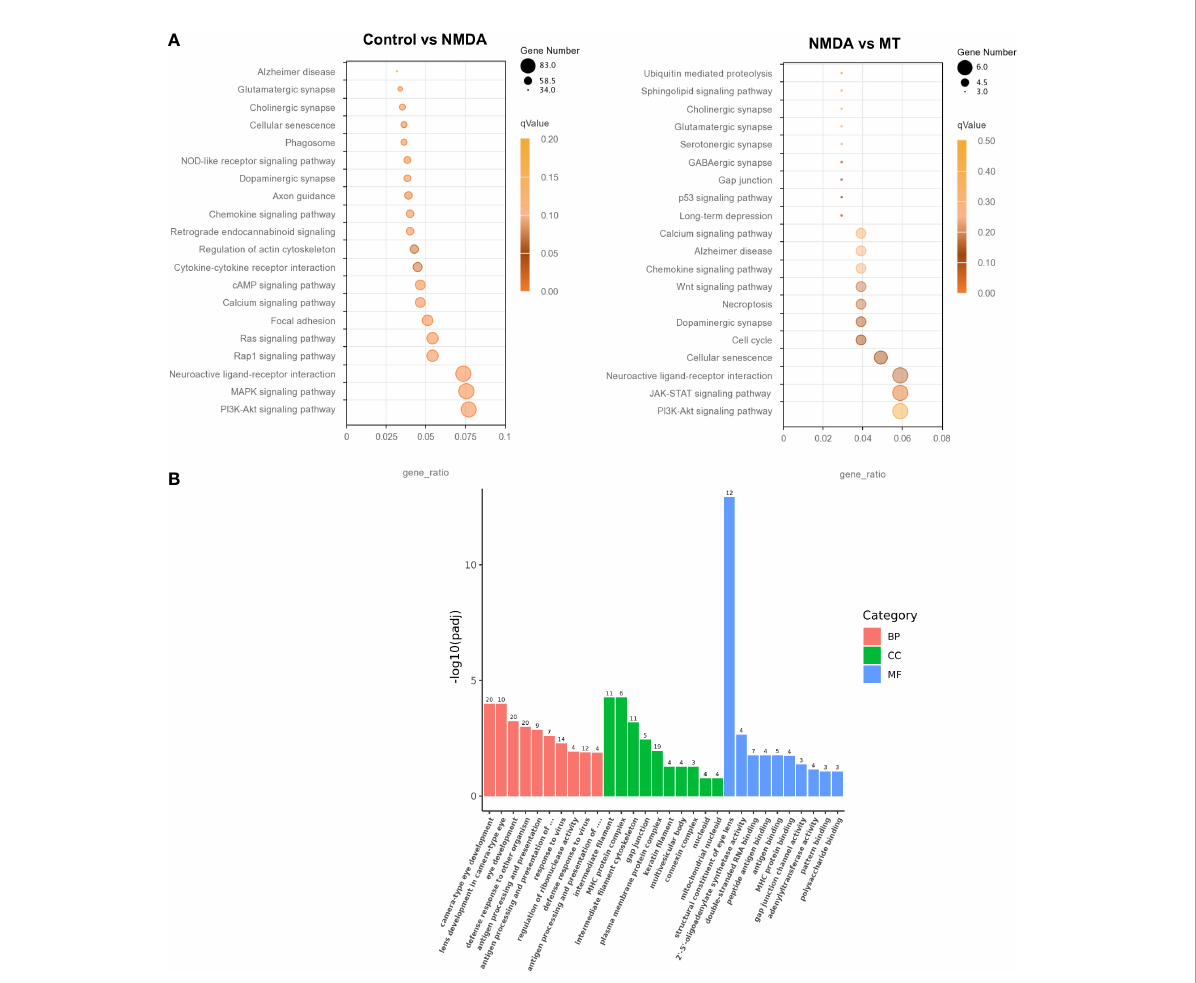
FIGURE 6 Analysis of differentially expressed genes in NMDA- and MT-treated mice retina. (A) KEGG analysis of differentially expressed genes between control, NMDA, and MT group. (B) Go analysis of differentially expressed genes between control, NMDA, and MT group in biological process (BP), cellular component (CC), and molecular function